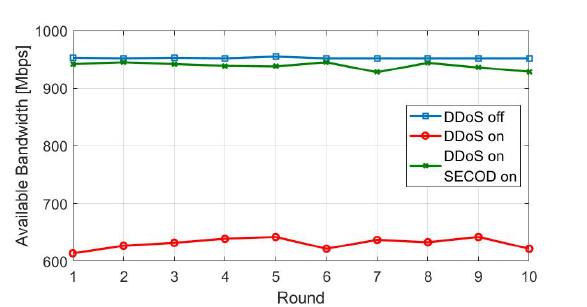
Figure 4. Comparison of available